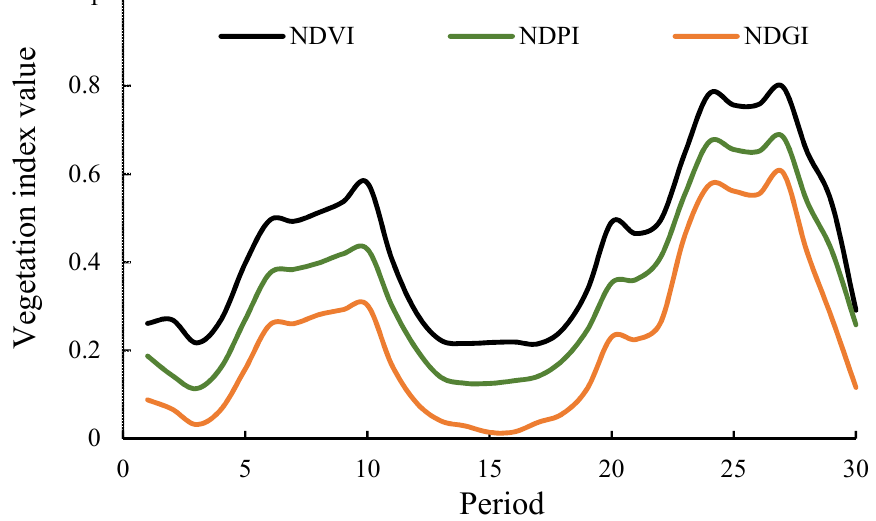
Figure 6. Reference curves for winter wheat time series of vegetation indices.